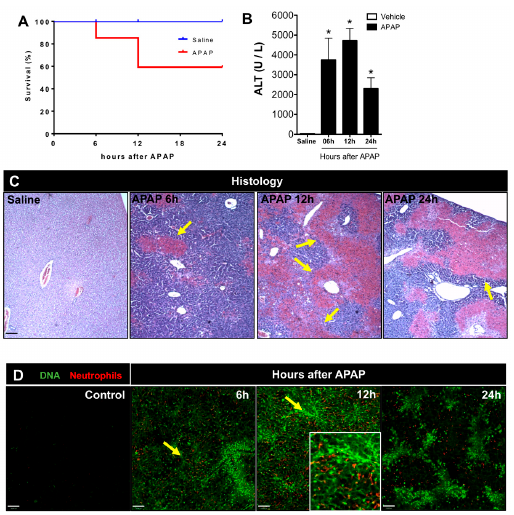
Figure 1. DNA deposition in liver microvasculature during acetaminophen (APAP)-induced injury. ( A ) Survival curve from mice ( n = 10/group) that were challenged with APAP or saline (control). ( B ) Alanine aminotransferase (ALT) levels in serum to assess hepatic injury at 6, 12, and 24 h after APAP administration. ( C ) Liver histology at different times after APAP administration evidencing hepatic injury; coloration Hematoxylin & Eosin (HE); 40 × magnification. Arrows show areas of extensive necrosis; scale bar = 100 µ m ( D ) Liver intravital confocal microscopy at different times after hepatic injury; green: Sytox Green; red: anti-Ly6G; scale bar = 300 µ m; 100 × magnification. (Mean ± SEM; n = 4); * p ≤ 0.05. Arrows show areas of massive DNA accumulation (necrosis), and the insert in the 12-h panel shows accumulation of neutrophils within DNA-rich areas (magnification 4 ×